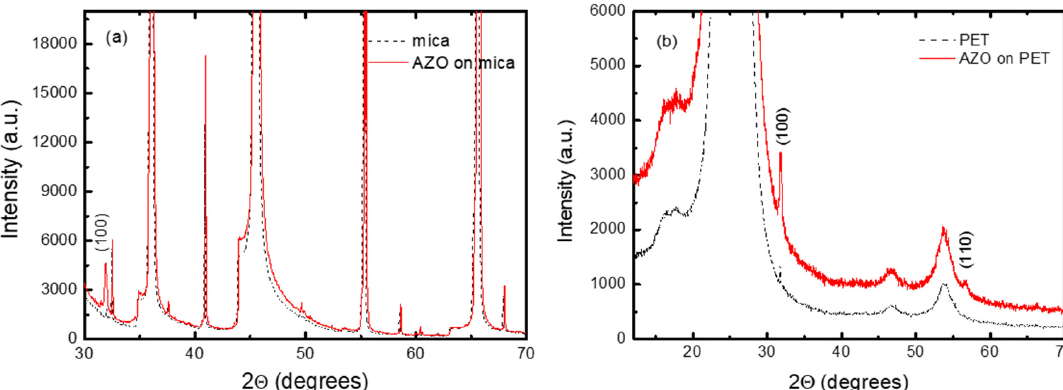
Figure 2. Detailed XRD patterns of ( a ) AZO on mica and ( b ) AZO on PET (blank mica and PET are included as references).